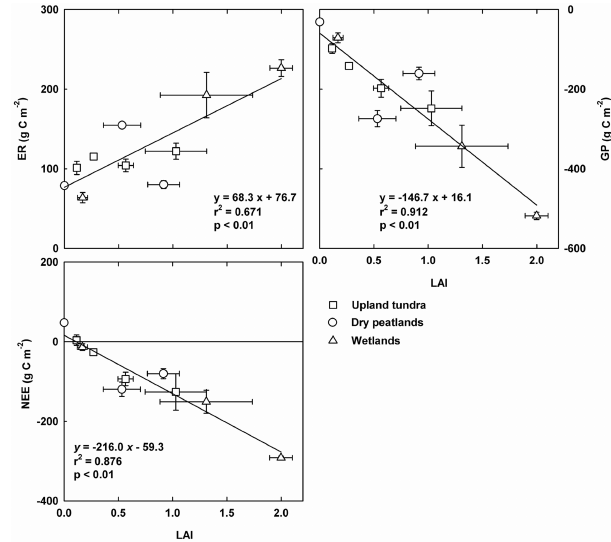
Fig. 6. Dependence between mean LAI and cumulative C fluxes for the growing season 2008 (days 168–246). Each data point repre- sents one of the ten chamber microsites (mean ± SD; n =